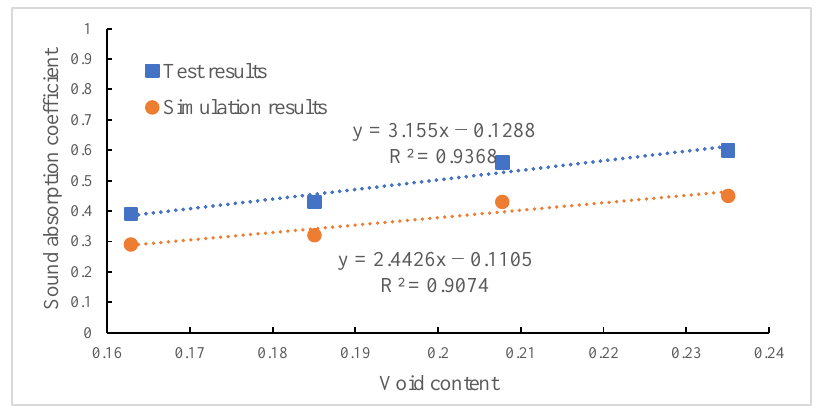
Figure 14. Mean SAC.